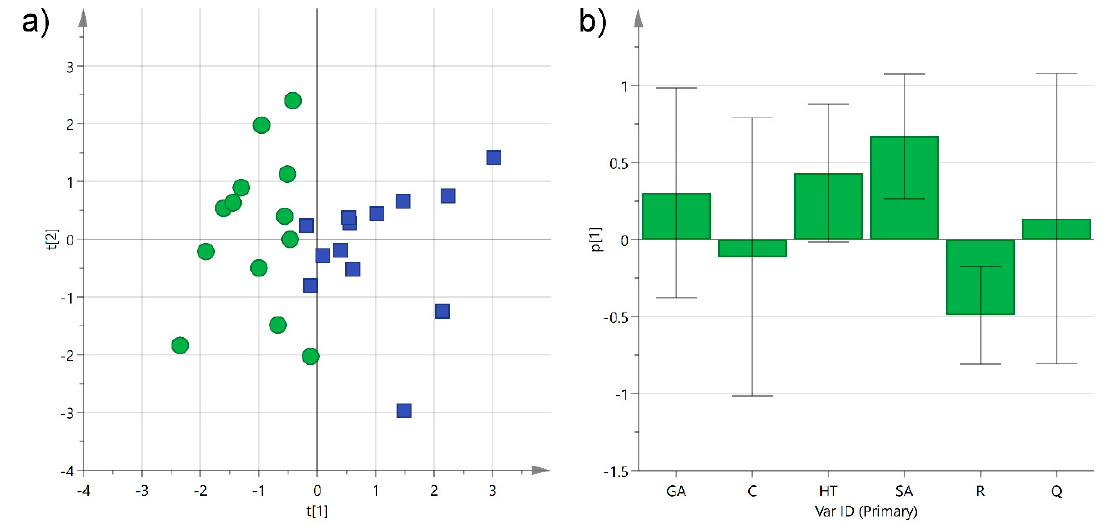
Figure 5. ( a ) Principal component analysis (PCA) score plot of PC1 ( R 2 X 0.29) versus PC2 ( R 2 X 0.25) for Negroamaro (green circles) and Primitivo (blue squares) wine samples; ( b ) histogram plot for the loadings of PC1. GA: gallic acid; C: catechin; HT: hydroxytyrosol; SA: syringic acid; R: trans -resveratrol; Q: quercetin.